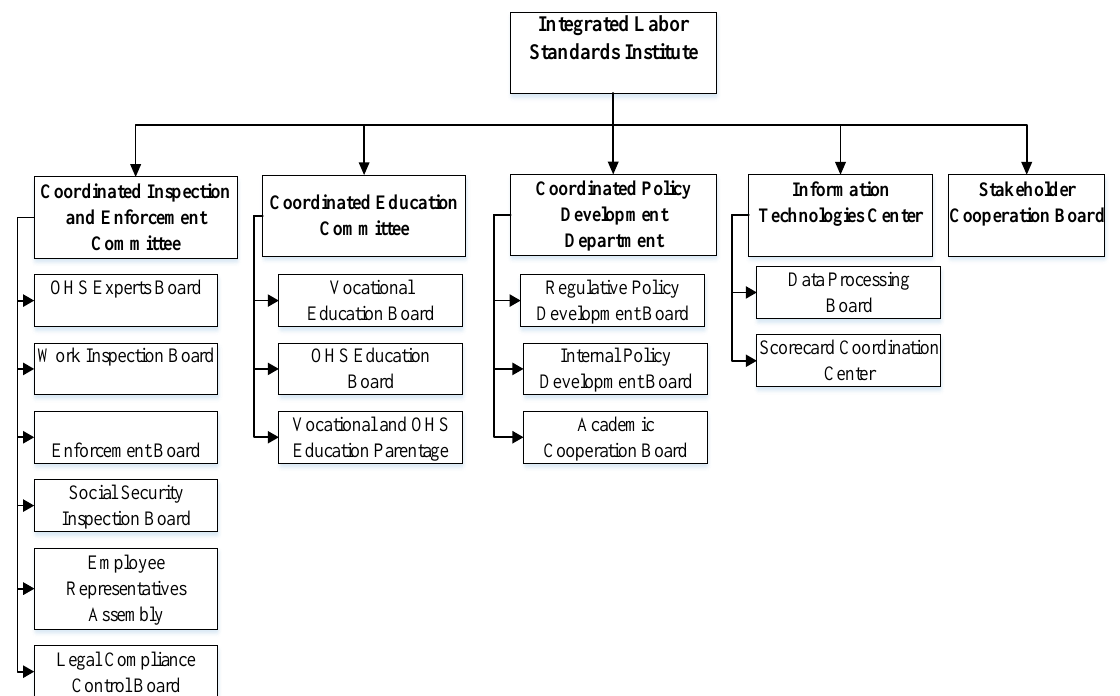
Figure 7. Organizational Chart of the Proposed Integrated Labor Standards Institute. Figure 7 and Table 5 list this institutional system’s units by the related labor stand- ards, principal roles, and the associated innovations introduced in the system design. Table 5. The Proposed Organization’s Main Roles and Innovative Actions.